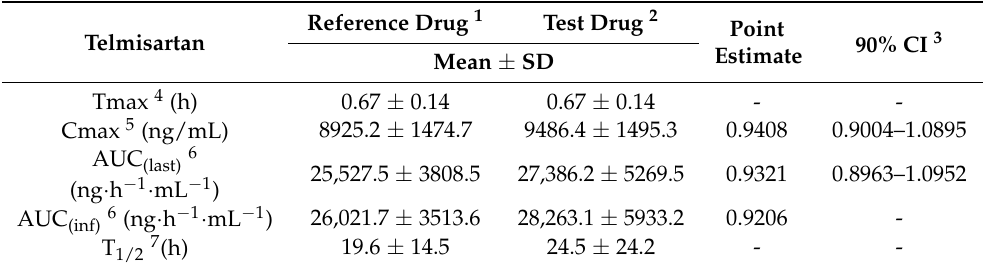
Table 4. Pharmacokinetic parameters of Twynstar ® and TA tablets at a dose of 80 mg telmisartan base in beagle dogs.